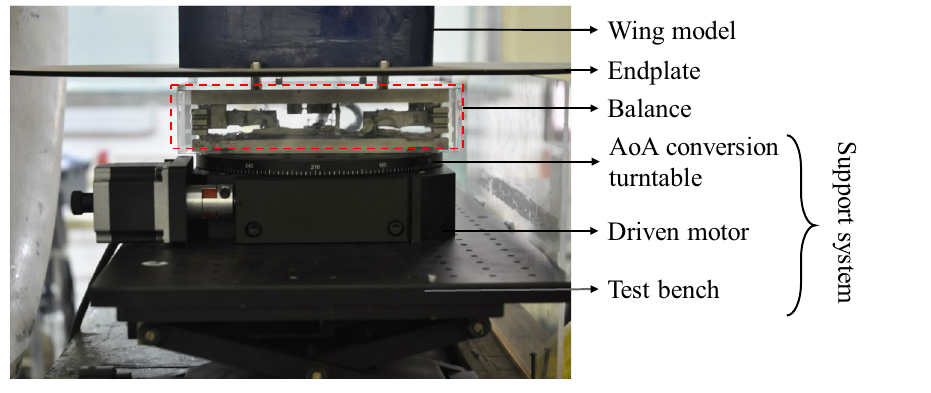
Figure 3. The balance and support